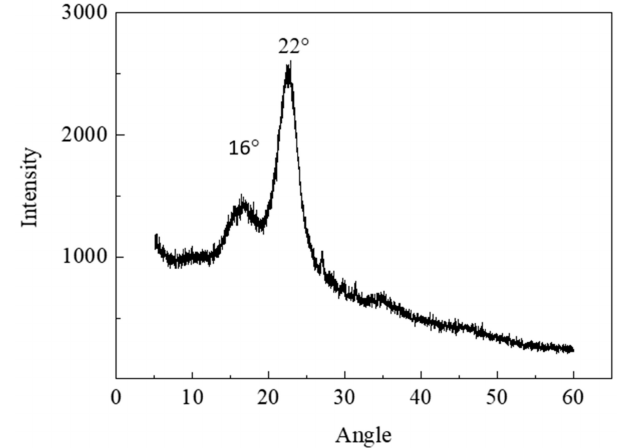
Figure 2. X-ray di ff raction pattern of untreated poplar catkin